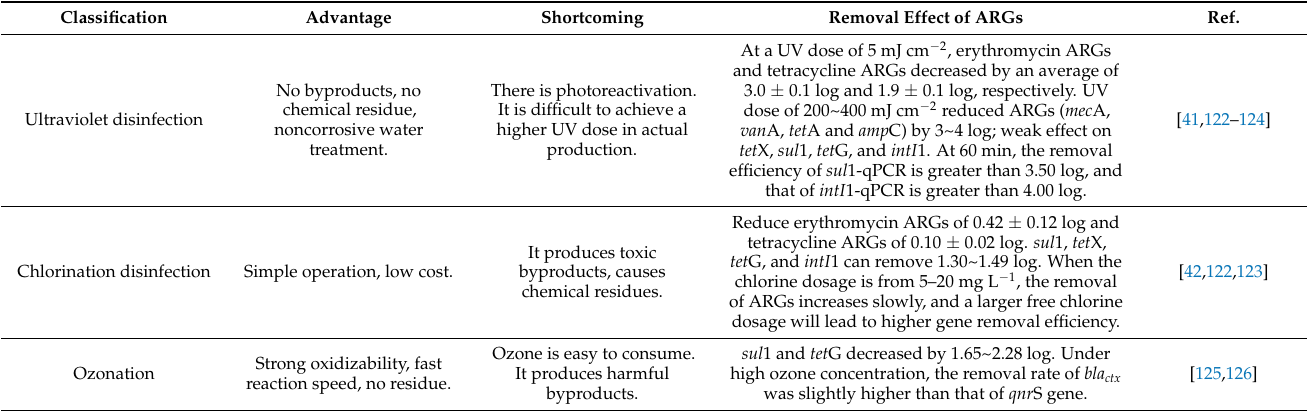
Table 4. Advantages and disadvantages of different ballast water disinfection methods and removal effect of